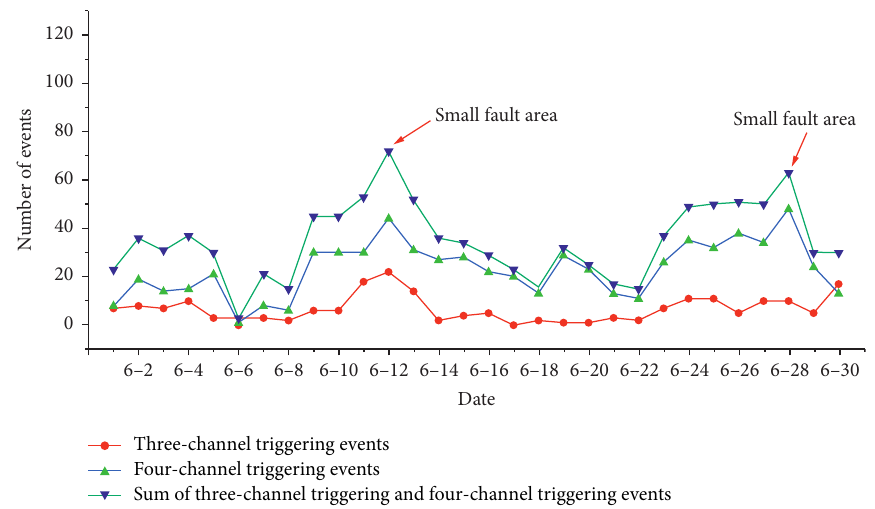
Figure 11: Relationship between the occurrence number of large MS events and fault